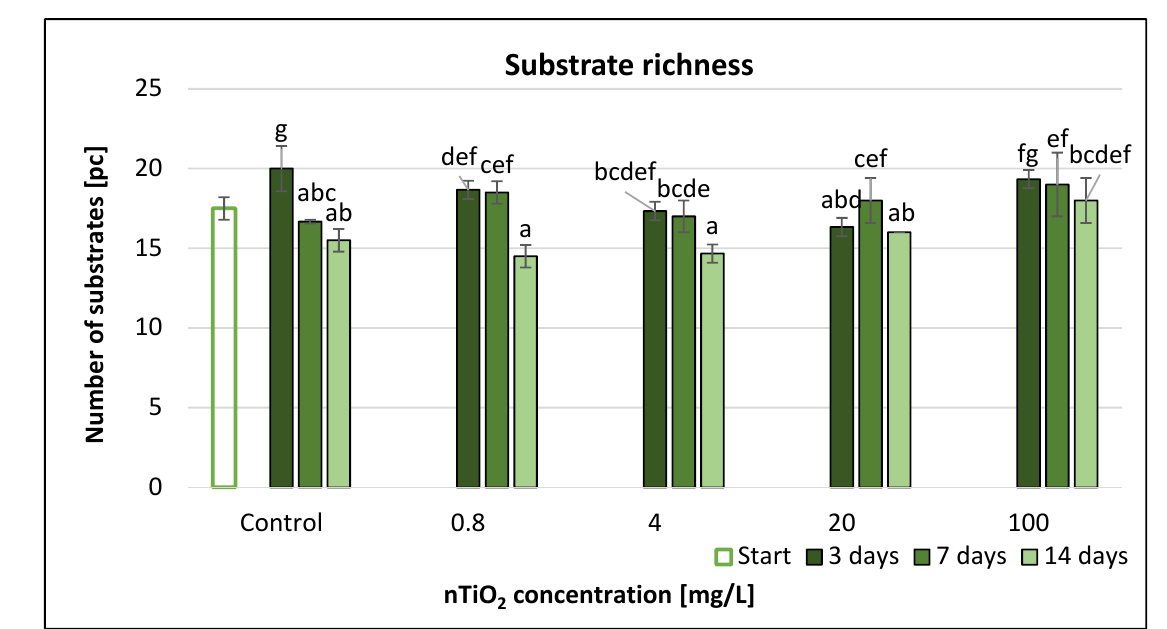
Figure 11. The effect of TiO 2 nanoparticles on freshwater substrate richness value. Letters on the columns indicate significant differences (level of significance: p < 0.05).